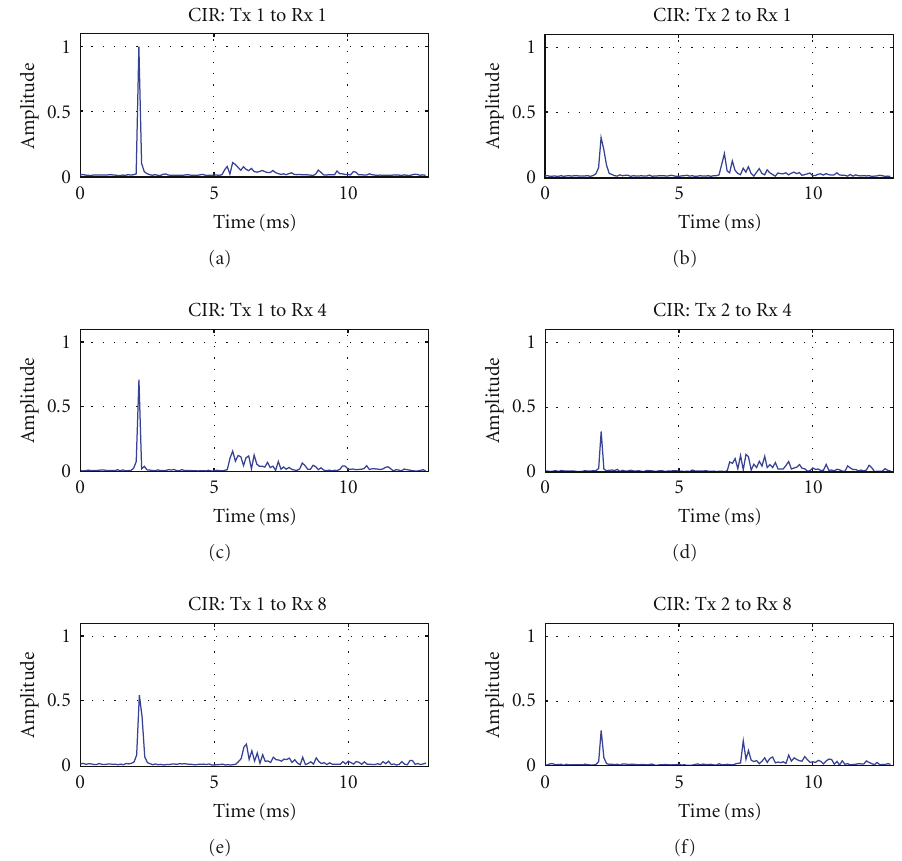
Figure 6: Estimated channel impulse responses for two-transducer eight-hydrophone transmission with QPSK modulation.